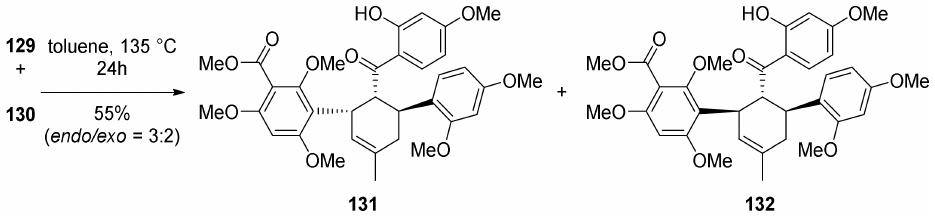
Figure 42. Thermal Diels–Alder reaction of diene 129 and dienophile 130